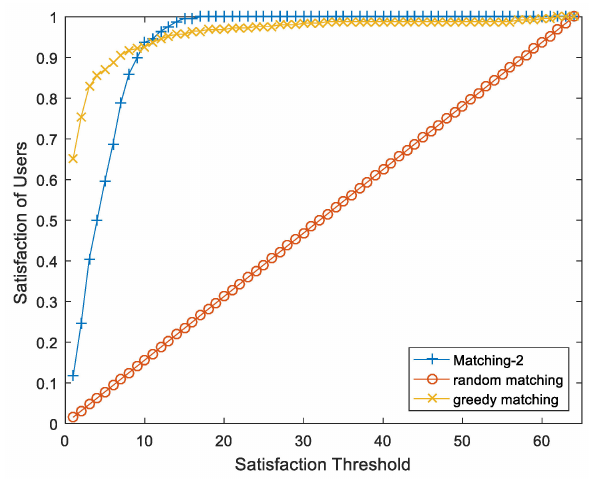
Figure 3. Users’ satisfactions versus satisfaction threshold ( n = 64, K = 8, J = 8).